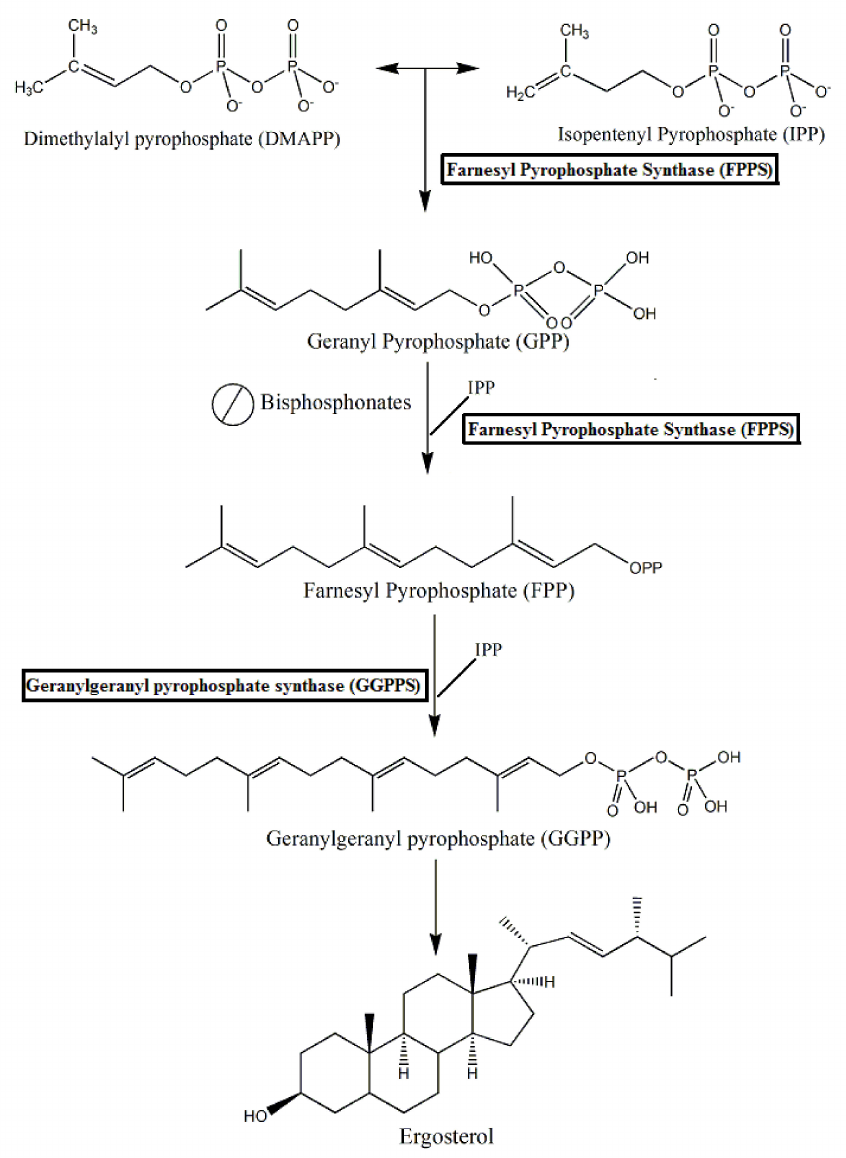
Figure 4. Schematic representation of the mevalonate pathway and the action of nitrogen-containing bisphosphonates. These compounds inhibit the enzyme farnesyl pyrophosphate synthase (FPPS), preventing the synthesis of farnesyl pyrophosphate (FPP) and geranylgeranyl pyrophosphate (GGPP) necessary for protein prenylation and subsequent ergosterol formation in eukaryotic